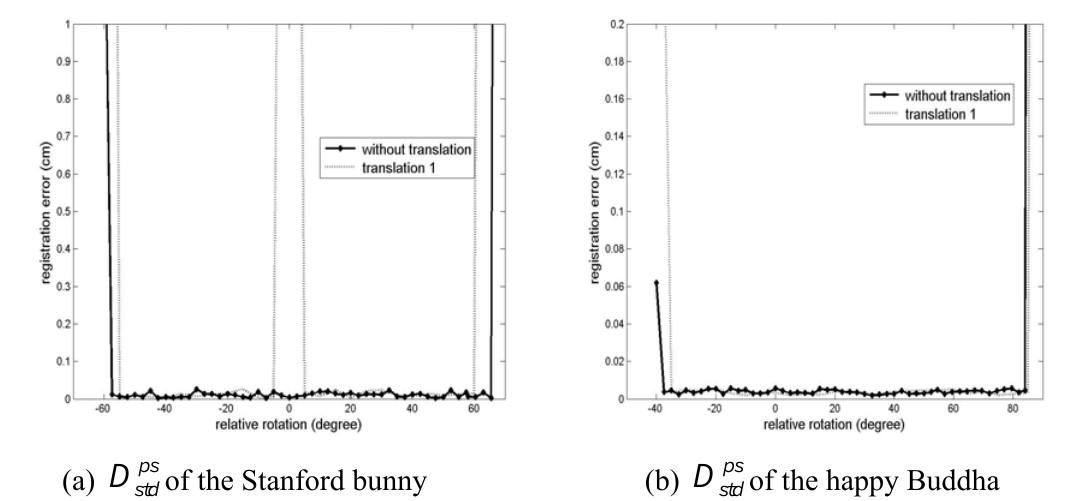
Figure 8. Convergence region tests of datasets from the Stanford 3D repository for the GP- ICP. The zero rotations of the curves represent different relative transformations of the ps D of the registered point clouds: the Stanford bunny and the data. (a) and (b) are the std happy Buddha,